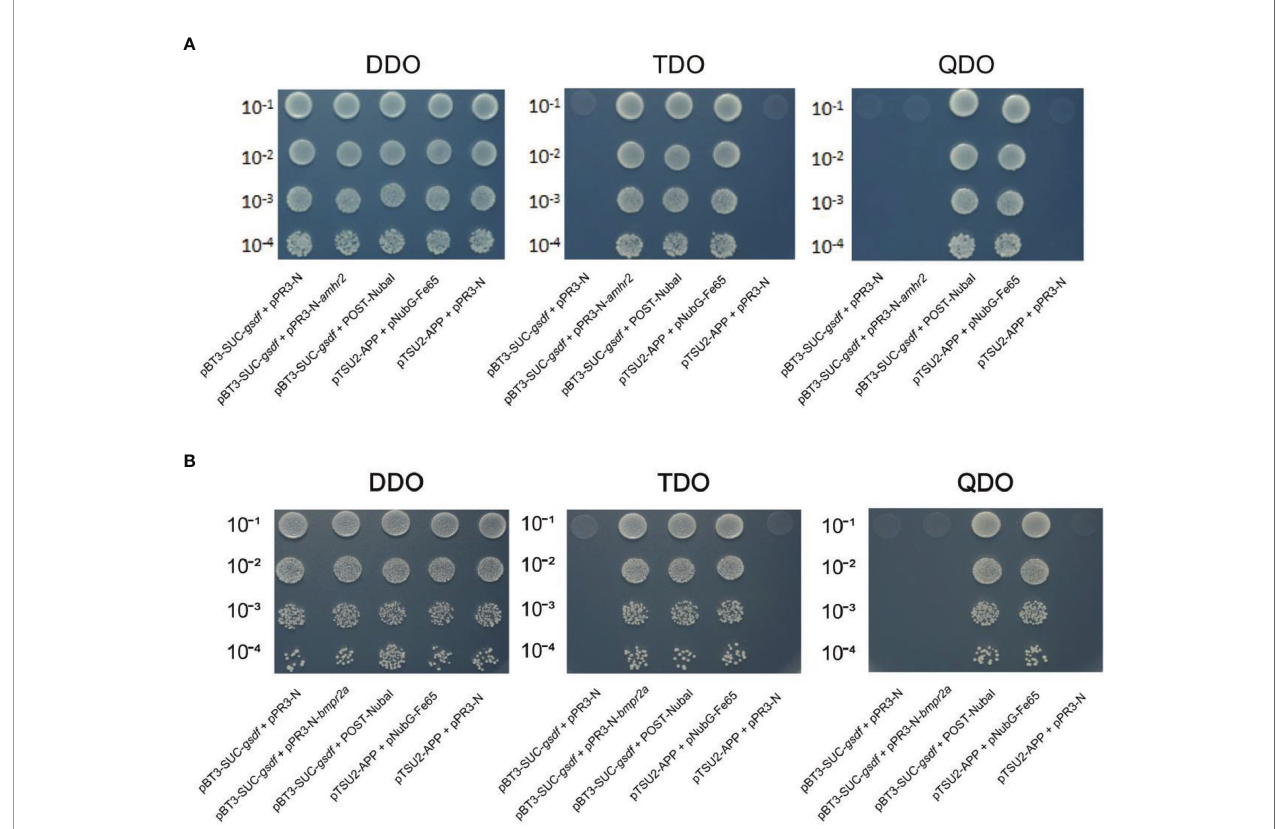
FIGURE 5 | Yeast-two-hybrid assays for Gsdf (bait) interaction with the prey [Amhr2 (A) and Bmpr2a (B) ] proteins. The hybridized yeast cell that survived on TDO and QDO plates indicate weak and strong positive interactions, respectively. The pBT3-SUC- gsdf + pPR3-N was set for detection of self-activation, while pBT3- SUC- gsdf + POST-Nubal was performed for functional veri fi cation of the ubiquitin system. The pTSU2-APP + pNubG-Fe65 and pTSU2-APP + pPR3-N were used as the positive and negative control,